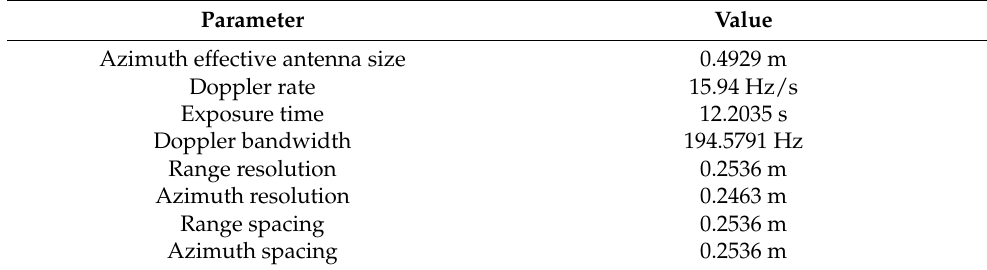
Table 4. Doppler coefficient & Resolution &